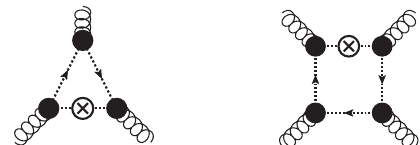
Figure 3: Ghost triangle (left) and ghost box (right) diagrams as they appear in the three- and four-gluon vertex flow equations [ 18 ] . As is well known, these ghost loops generate logarithmic divergences in the vertices. Similar diagrams contribute to the respective vertex DSEs, see e.g. [ 41–45 ]